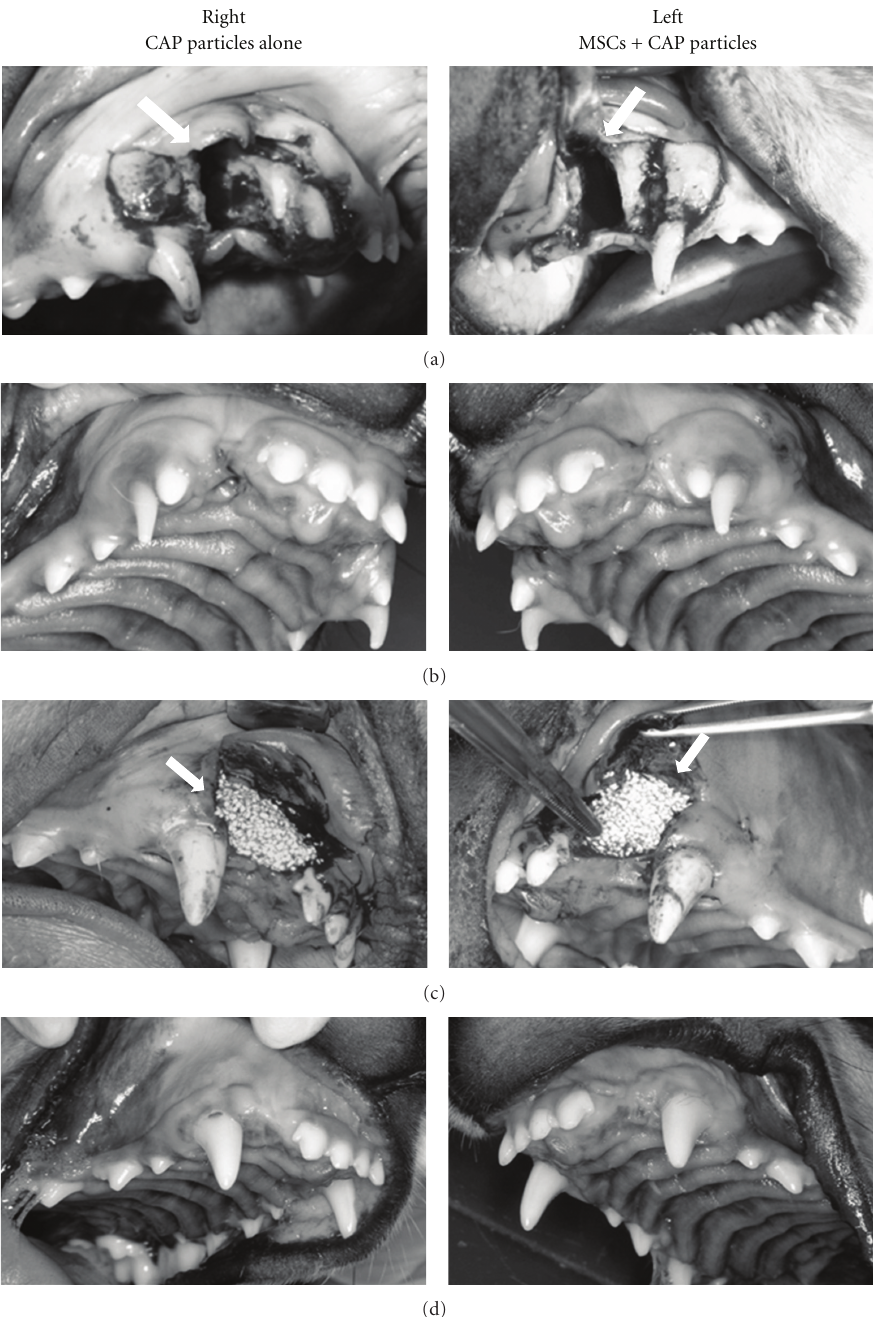
Figure 2: Intraoral findings before and after the transplantation of MSCs to artificial jaw cleft. Intraoral images (a) after preparation of bilateral artificial jaw cleft in maxilla (arrowhead, jaw cleft), (b) before and (c) after transplantation of MSCs with CAP particles to the jaw cleft (3 months after the preparation of artificial jaw cleft). The cleft on the right side (control side) was filled with CAP particles alone, whereas the cleft on the left side (experimental side) was filled with MSCs and CAP particles (arrowhead). (d) 6 months after the